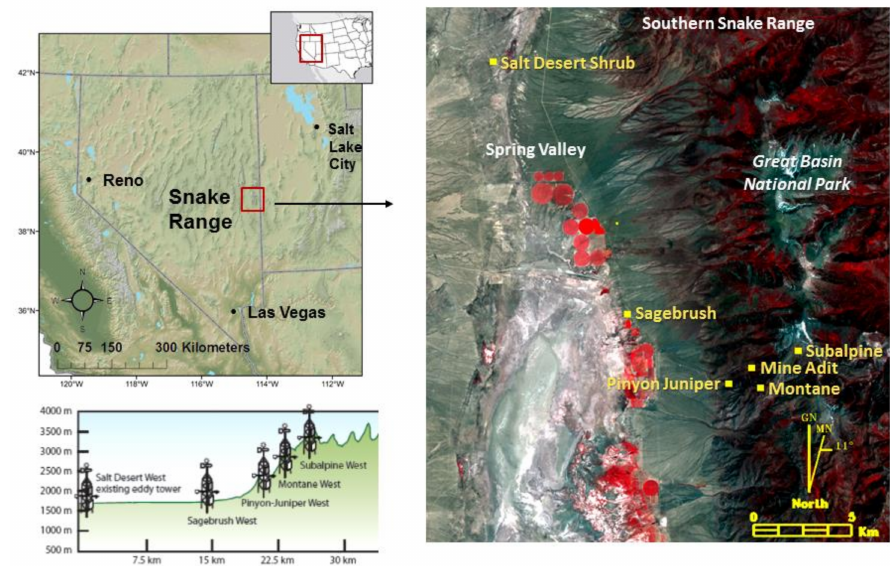
Figure 1. Site location map showing the monitoring sites located in east central Nevada portion of the Great Basin. Sites are on the western slope of the Southern Snake Range and within Spring Valley; geographic coordinates for each site are listed in Table 1. (16 June 2013 color infrared Landsat 8 image.). Area in red represents irrigated alfalfa